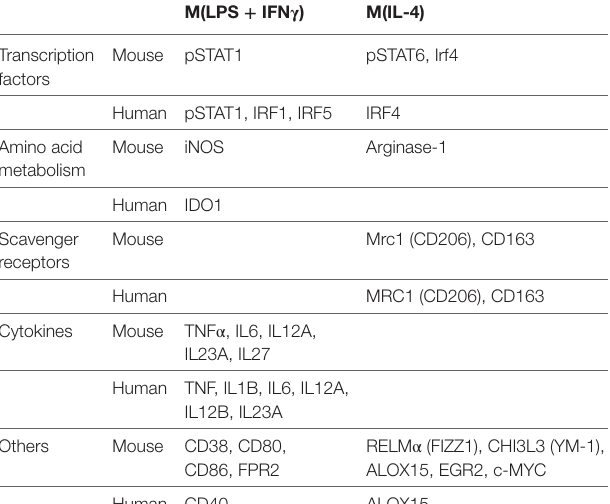
TABLe 1 | Inflammatory phenotype macrophage/microglia